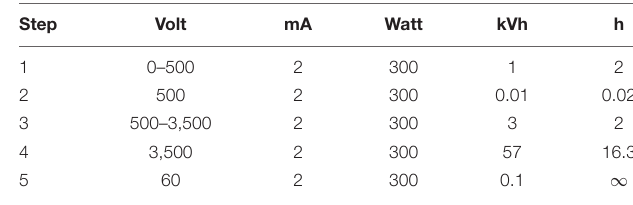
TABLE 1 | Power conditions for